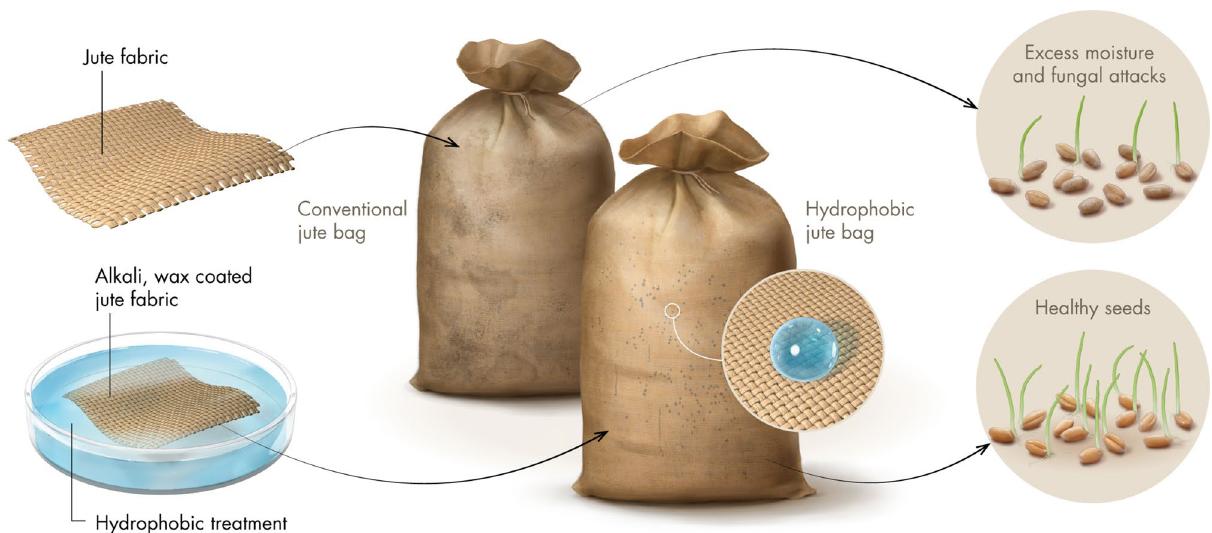
Figure 7. Schematic showing the surface treatments of jute bags with alkali and wax coating, the seed storage experiment, and the germination experiment for stored wheat grains. Control jute bags, CJBs; hydrophobic (wax-coated) jute bags, WCJBs. While CJBs accumulate water and get wet, WCJBs prevent water accumulation and cause water droplets to roll off their surface. Post-storage seeds from WCJBs are more likely to have higher germination than seeds from CJBs (image credits: Xavier Pita,